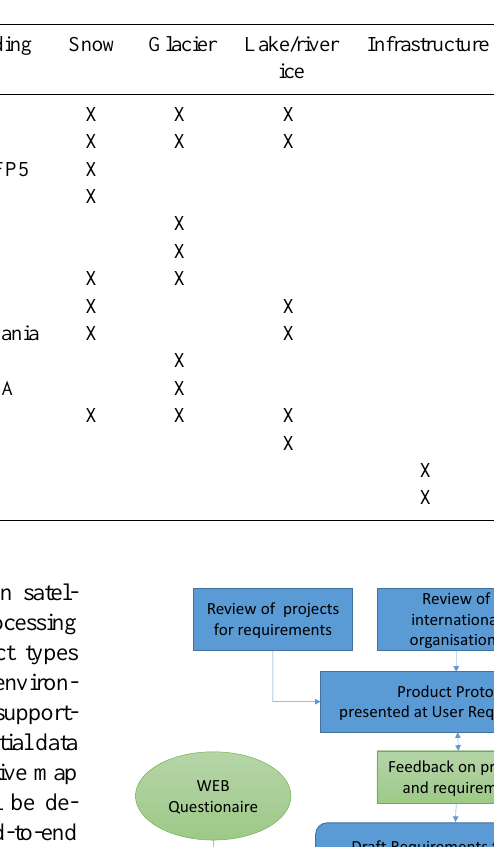
Table 1. List of projects/organizations that have performed user surveys and/or made recommendations for snow, glacier, lake/river ice products and web-map services lately.